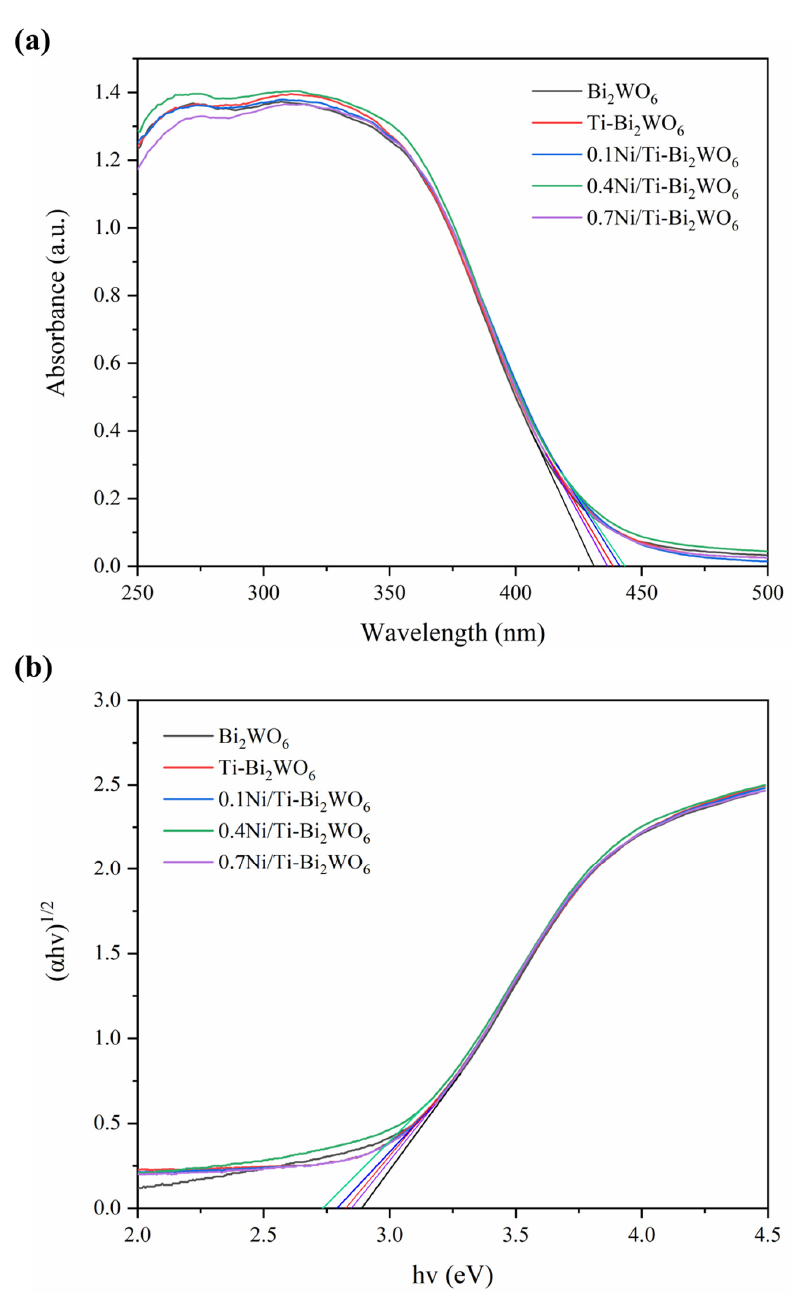
Figure 7. ( a ) UV-vis absorption spectra of over samples; ( b ) the corresponding plots of ( α hv) 1/2 versus hv for the band gap energy over samples.